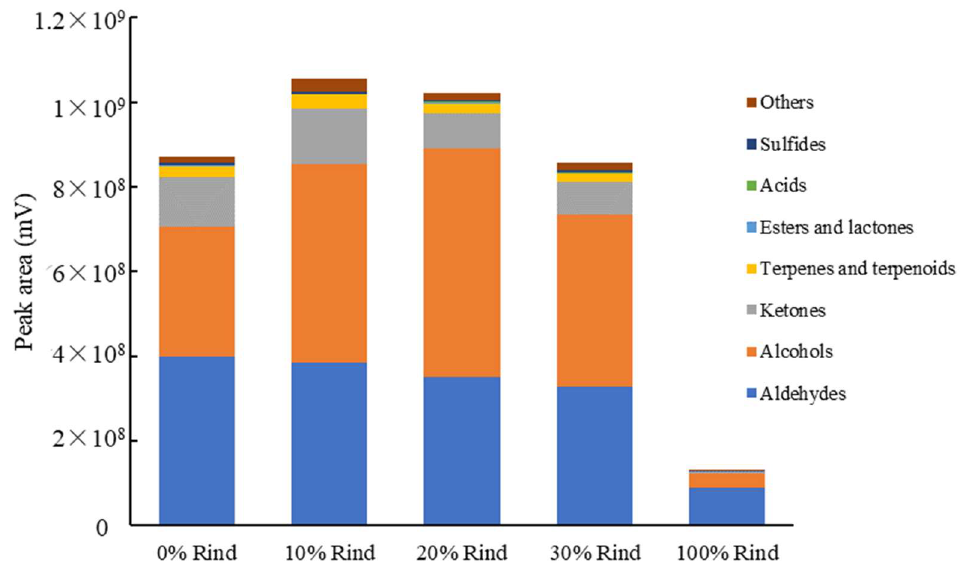
Figure 3. Abundance (peak area, mV) of grouped volatiles in watermelon rind, flesh, and rind-flesh blends using SPME-GC-MS analysis. blends using SPME-GC-MS